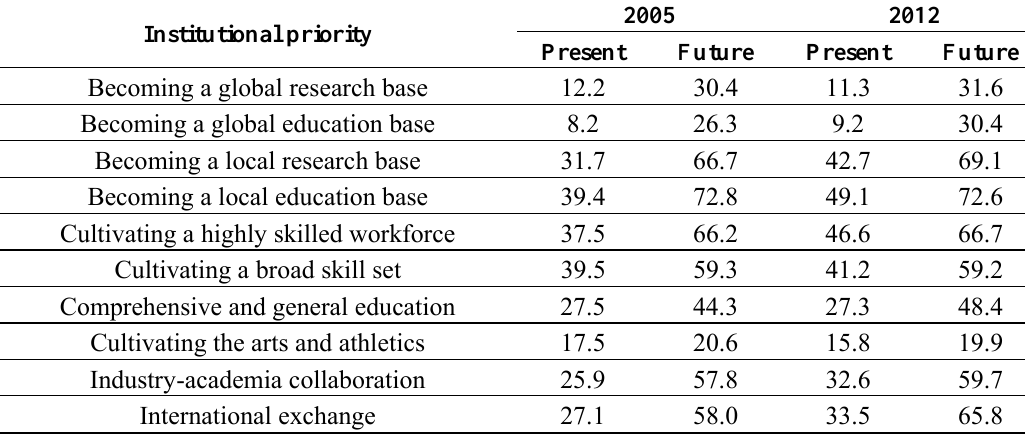
Table 2. Proportions of Japanese university executives acknowledging the listed academic priorities with positive